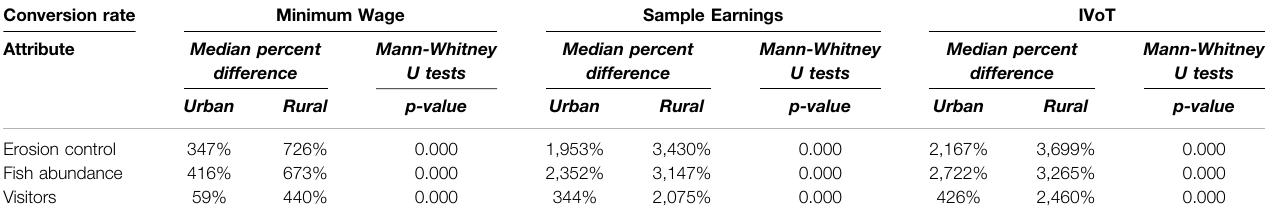
TABLE 8 | Results of the analysis procedure to compare urban and rural WTP disparities as described in Supplemental Appendix B . Including the results of the Mann- WhitneyUtestsonwhetherthesizeoftheWTPdisparitiesdifferssigni fi cantlyacrosstheurbanandruralstudysites,andthemedianofthepercentdifferences( PDs )that represent the WTP disparities between WTP money and WTP time based on the different conversion rates in each site. Conversion